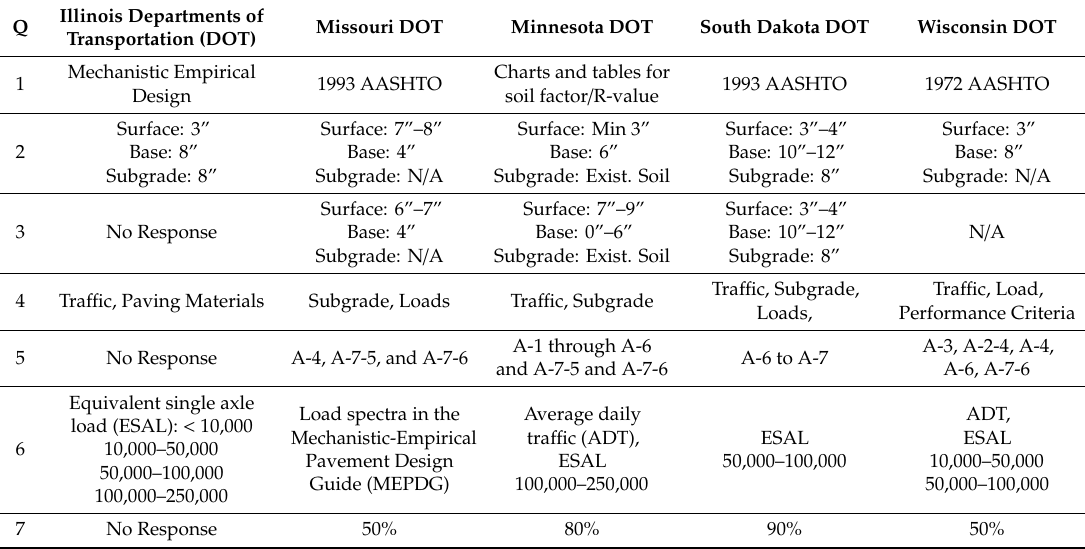
Table 2. Survey results from five adjoining states about their pavement design